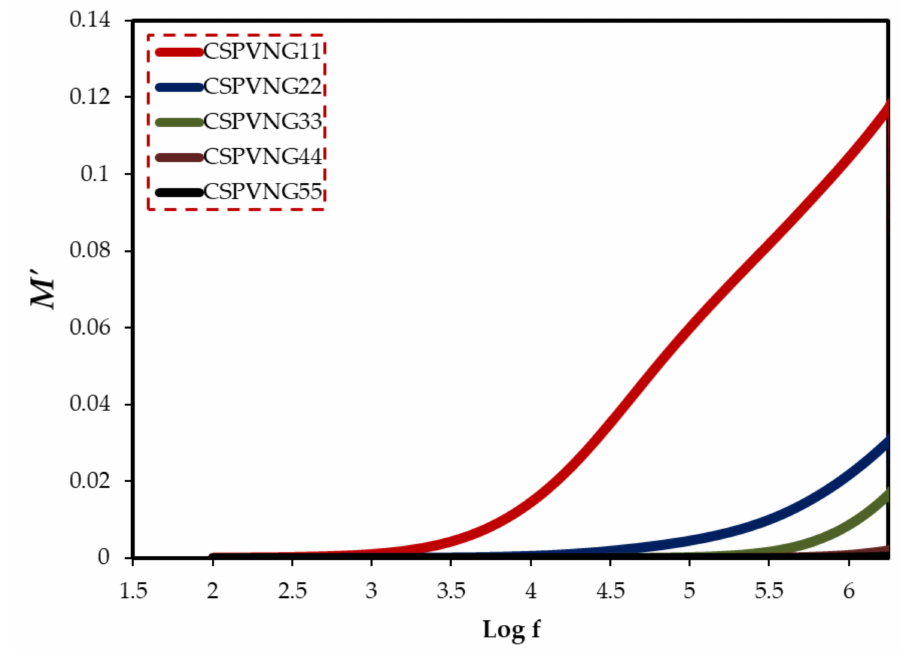
Figure 12. The real part of the electric modulus versus log (f) for the electrolyte samples.